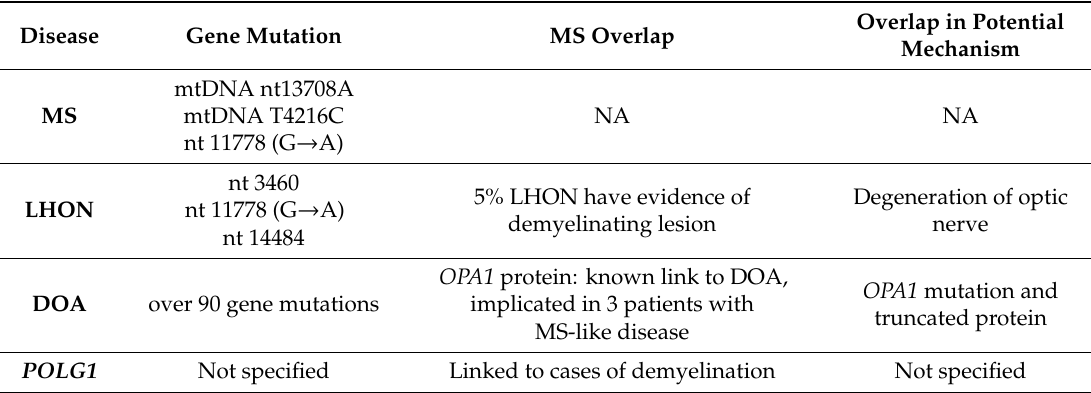
Table 3. Associations between MS and mitochondrial